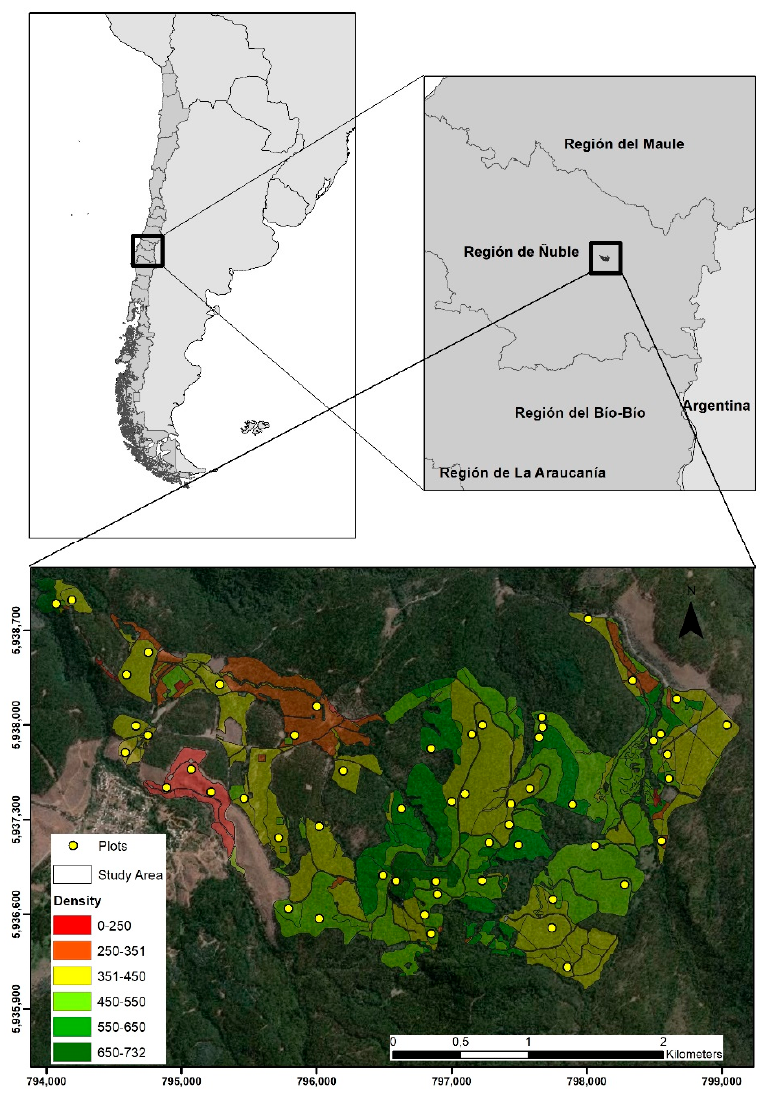
Figure 1. Study area and locations of sample plots in the Ñuble Region (Chile, WGS84 UTM18S). Table 1. Silvicultural characteristics of Pinus radiata stands in the Ñuble Region (Chile, N = 48 field plots).